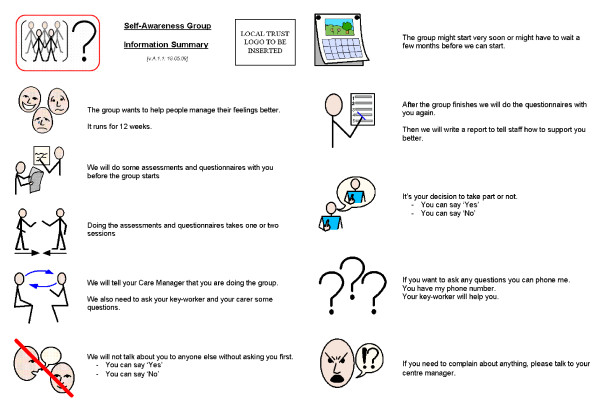
Accessible information sheet.